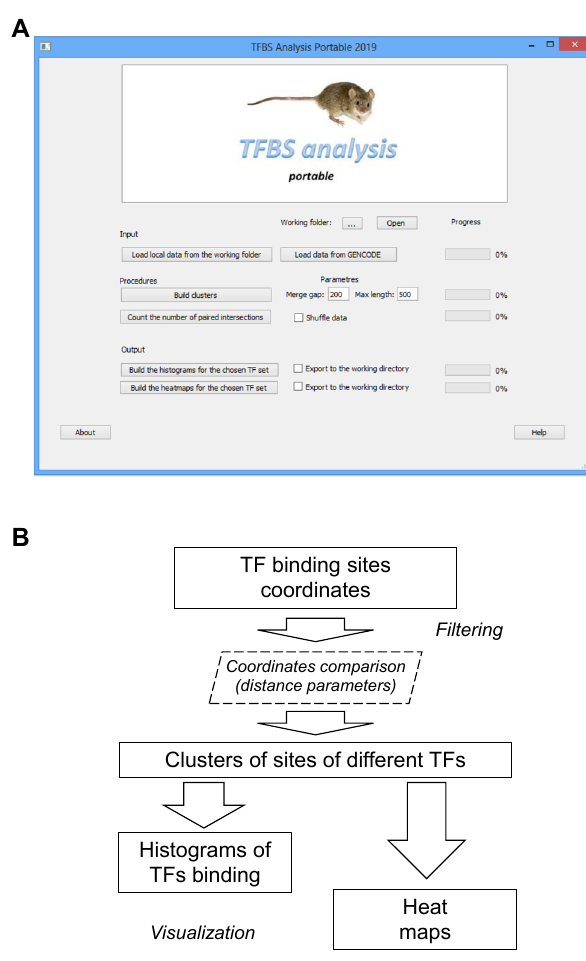
Figure 1: TFBS analysis